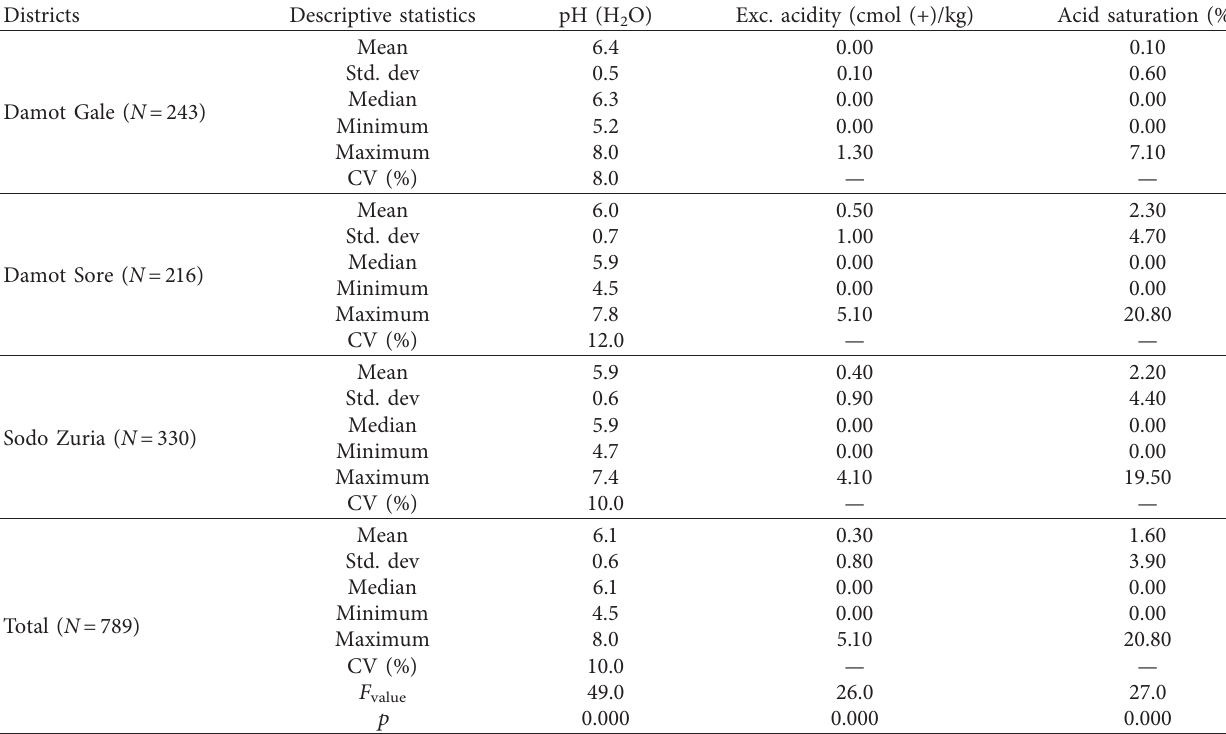
Table 3: Descriptive statistics of soil pH, exchangeable acidity, and acid saturation for surface soils.